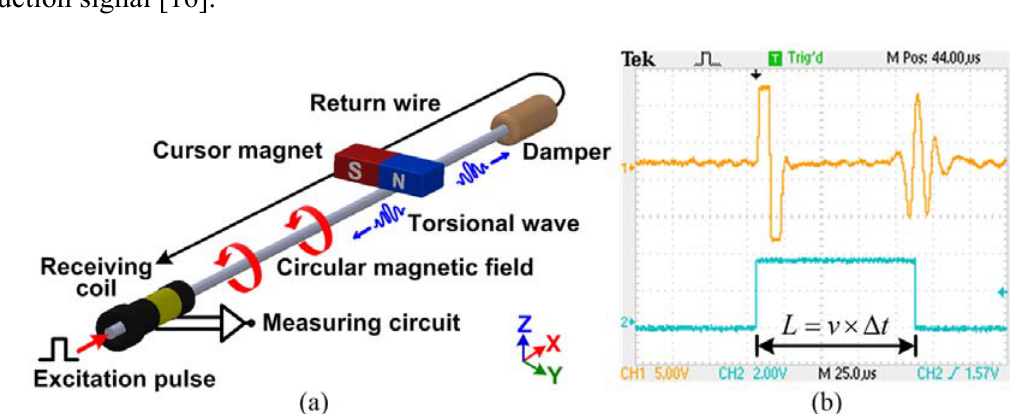
Figure 1. MLPS principle. ( a ) MLPS operation; ( b ) Oscilloscope waveform of the induction signal